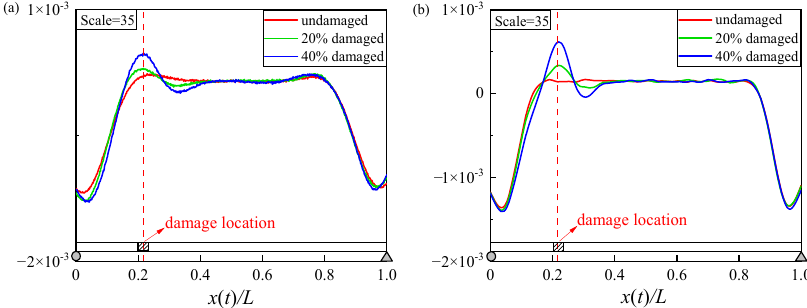
Figure 9. CWC extracted using different methods: ( a ) EEMD; ( b ) CEEMDAN.